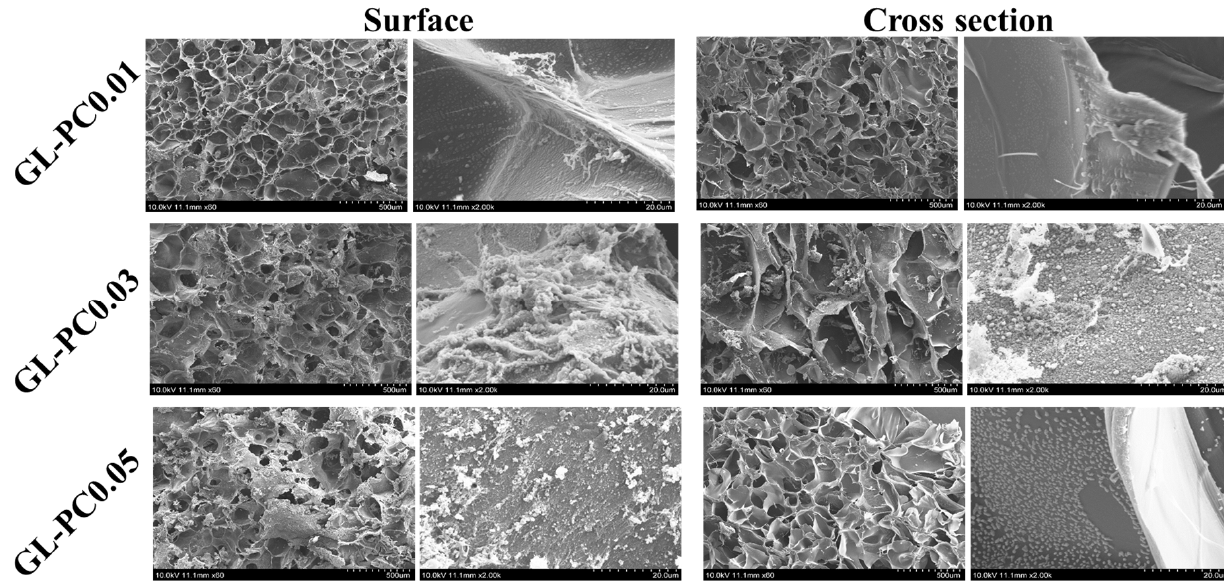
Figure 4. SEM images of GL-PC freeze dried hydrogels. One of the primary characteristics of the biocompatibility of hydrogels is swelling, which occurs when the hydrogel matrix absorbs a significant amount of water and has characteristics similar to those of living tissues in terms of physiological stability and nutritional permeability [4]. The immersion of the freeze-dried hydrogels in PBS (pH 7.4) showed a significant water uptake within 1 h of incubation. The abundance of catechol groups in PCs, which are readily solvated in water, caused the swelling to increase as the concentration of PCs in the hydrogels increased (Figure 5). The equilibrium swelling was achieved within 70 h of incubation in the PBS solutions. The GL-PC0.05 hydrogel showed the maximum swelling capacity due to both the solvation of the hydrophilic segments and pore filling by the PBS solvent, since the hydrogels have good porosity [15,16].